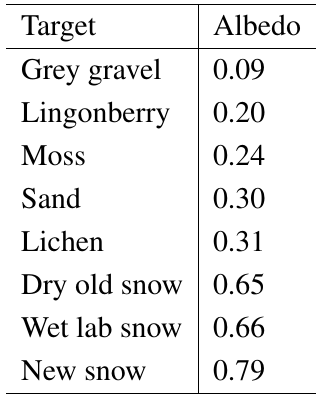
Table 1. The broadband albedo values of various targets at the sun zenith value of 60 ◦ obtained by direct integration of the measured